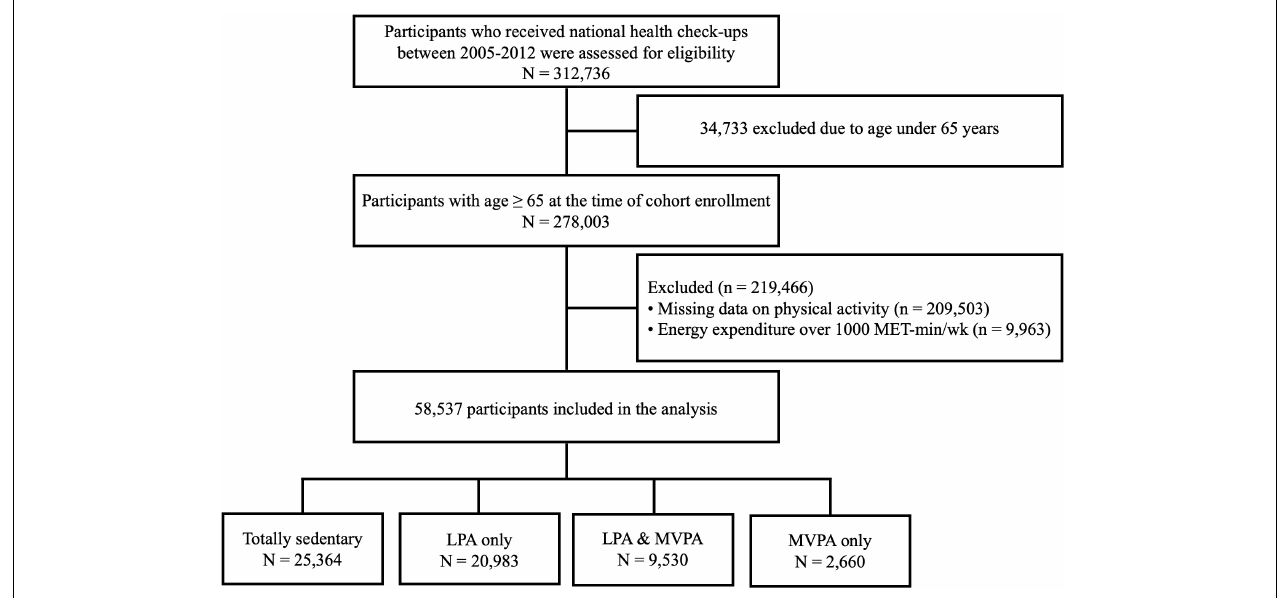
FIGURE 1 | Summary of the statistical analysis design. LPA, light intensity physical activity; MVPA, moderate- to vigorous-intensity physical activity; MET, metabolic equivalent of